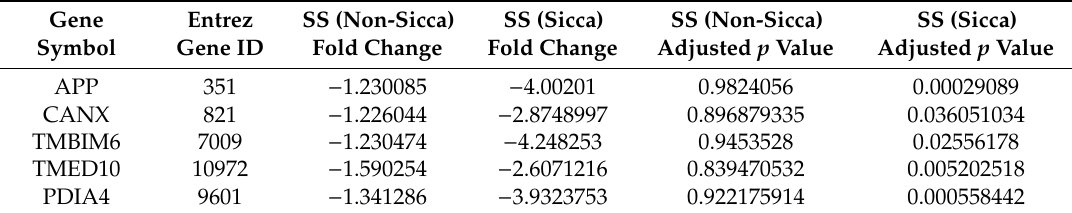
Table 3. Comparison of TMED10, PDIA4, CANX, APP, and TMBIM6 gene expression in SS patients with xerostomia SS (sicca) and without xerostomia SS (non-sicca) and HS.